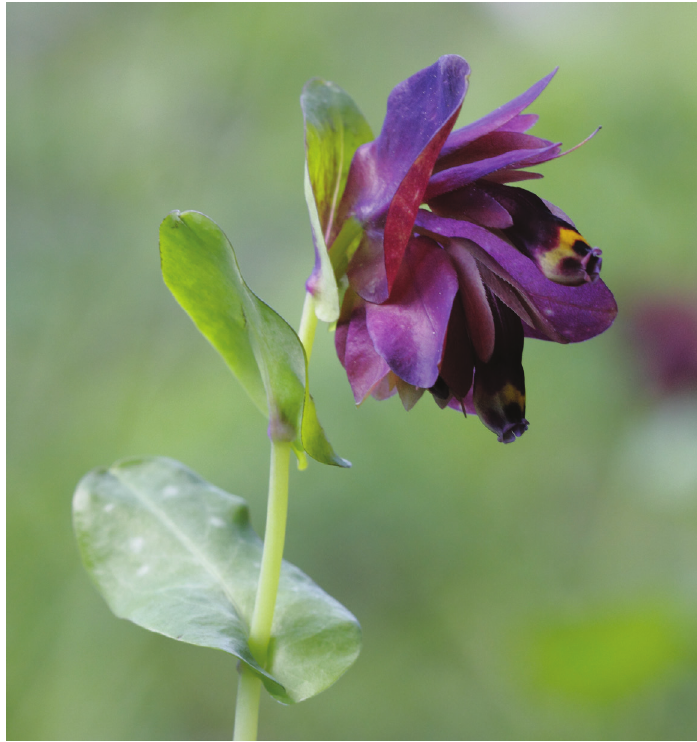
Figure 3. Cerinthe retorta in Valle dell’Inferno (San Giovanni Rotondo, Italy). Picture by R.P. Wagen- sommer.